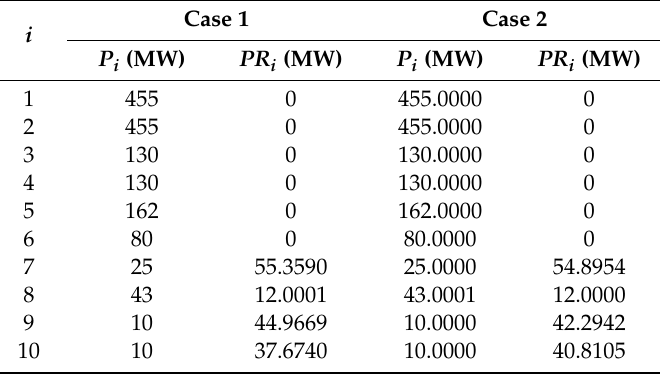
Table A4. Optimal solutions for the 10-unit system obtained by